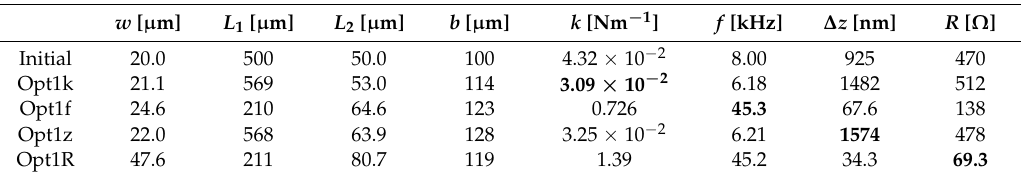
Table 2. Single-objective optimization Opt1k results.